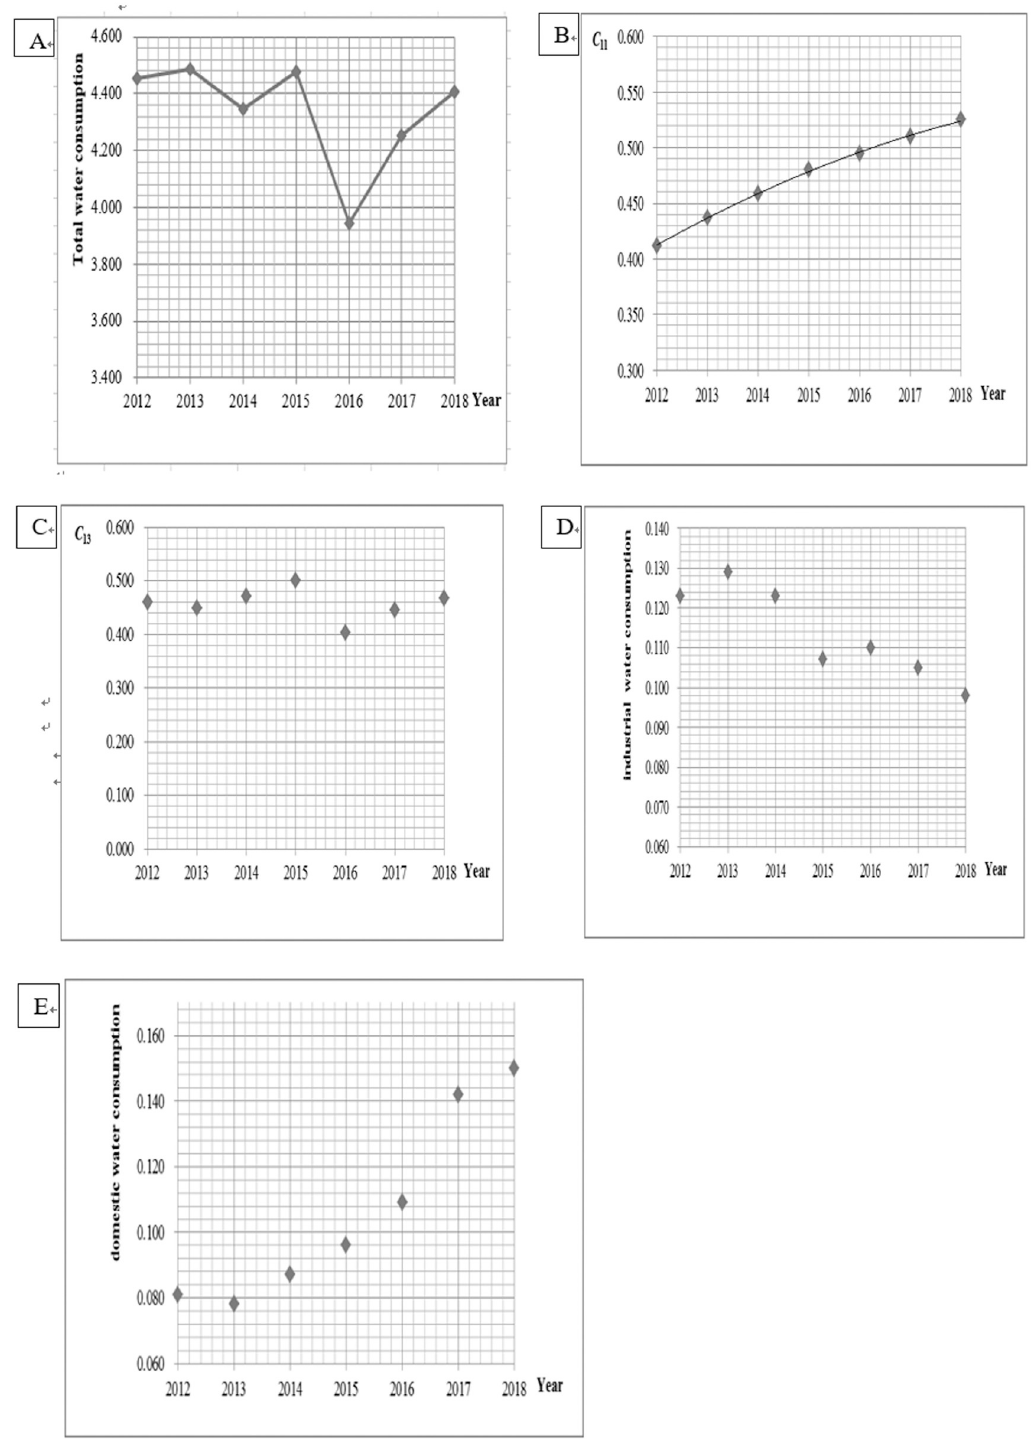
Fig 3. Changes of each indicator from 2012 to 2018. (a) Change of total water consumption. (b) Change of utilization coefficient of farmland irrigation water. (c) Change of water consumption rate. (d) Change of industrial water consumption. (e) Change of domestic water